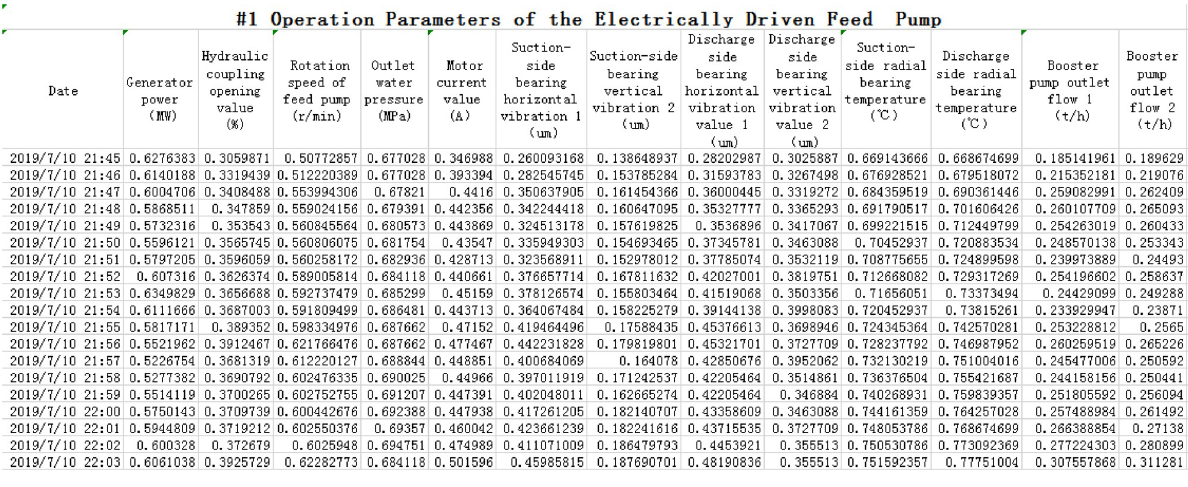
Fig 8. Normalized data screenshot.